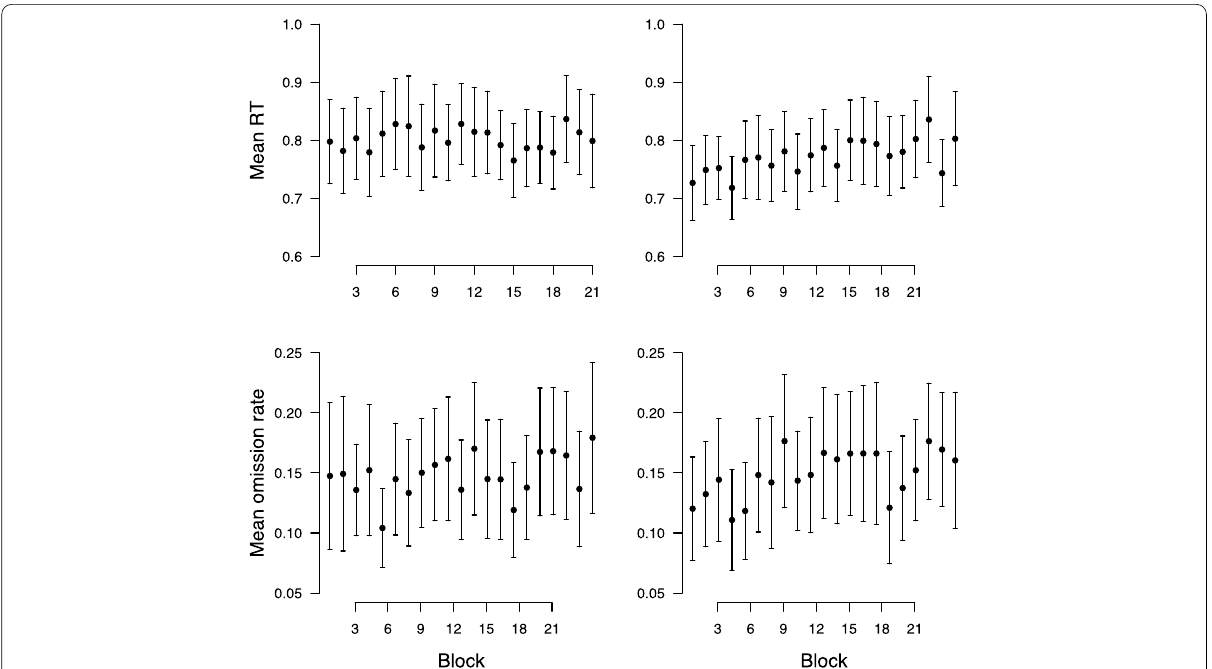
Fig. 4 Development of DRT performance across blocks. Top row: mean RT across blocks. Bottom row: mean omission rate across blocks. Error bars show mean ± 1.96 SEM